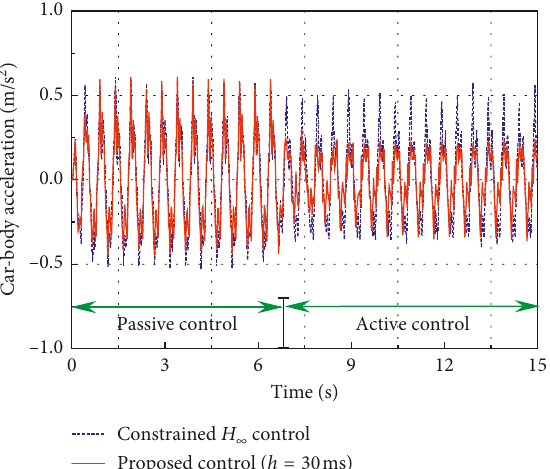
Figure 15: Hardware results of car-body acceleration under si- nusoidal wave signal.